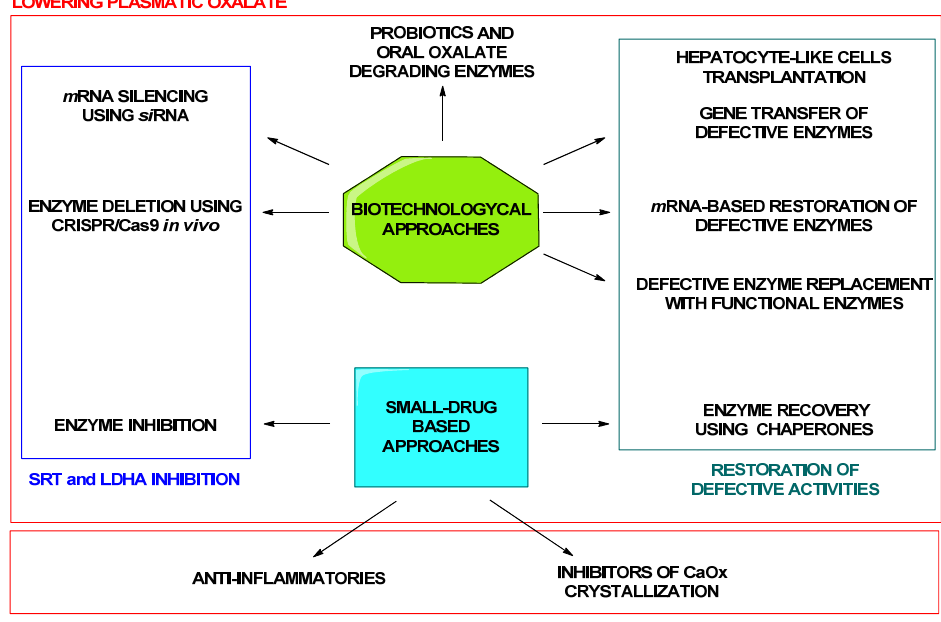
Figure 3. Summary of biopharmaceuticals and small drug approaches under development for the treatment of PHs. treatment of